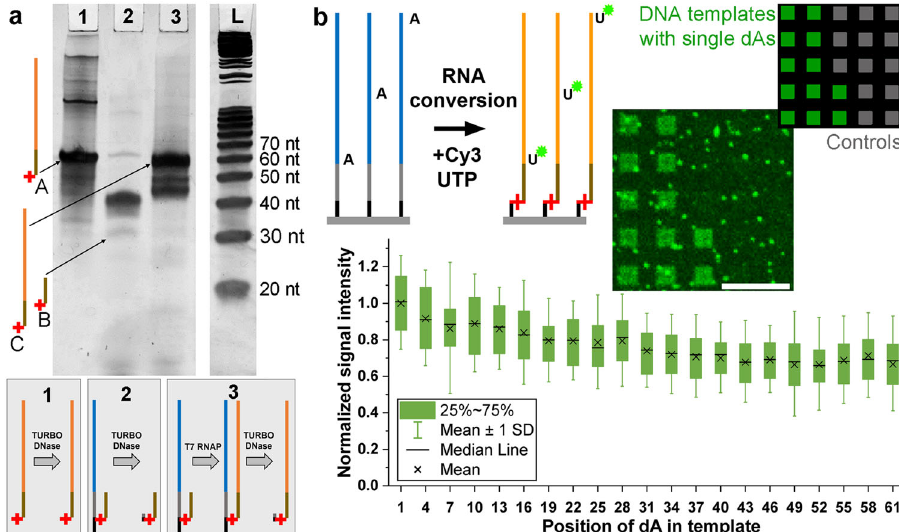
Fig. 3 Ef fi ciency of 2 ′ - O -methyl RNA primer extension by the T7 RNA polymerase. a PAGE analysis of primer extension in solution. Lane 1: a 57 nt reference product oligonucleotide made using conventional solid-phase synthesis and consisting of a 5 ′ -psoralen 27 nt 2 ′ - O -methyl RNA section and a 3 ′ 30 nt RNA section (arrow A) plus TURBO DNase. Lane 2: 62 nt DNA reference of template and linker made using conventional solid-phase synthesis and crosslinked to the 27 nt 2 ′ - O -methyl RNA primer, followed by DNase degradation. Degradation products are the primer crosslinked to DNA fragments and residual primer (arrow B). Lane 3: product of the full enzymatic conversion and template degradation of the conventionally synthesized and crosslinked oligonucleotides used in lane 2, with arrow C showing the full-length RNA extension of the 2 ′ - O -methyl RNA primer. The steps performed on each sample loaded into lanes 1-3 are illustrated in the scheme below. b The ef fi ciency of on-array primer extension of in situ synthesized DNA is demonstrated